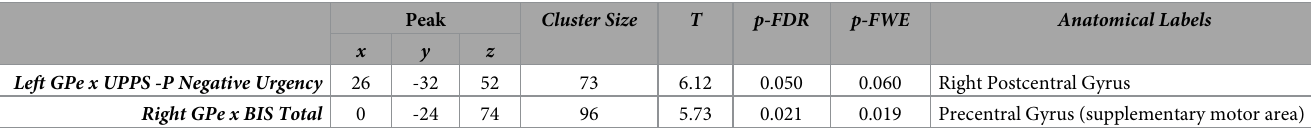
Table 4. Associations between alcohol induced changes in GPe connectivity and impulsivity